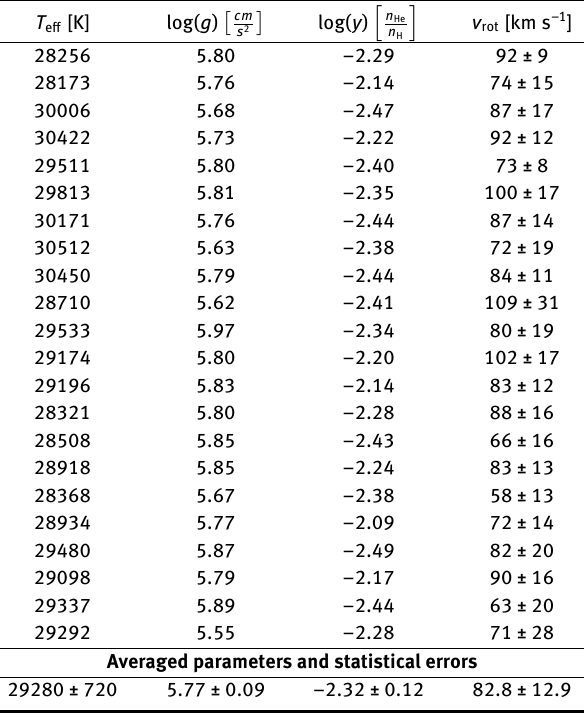
Table 3. Atmospheric parameters of PTF1 J0113. Their values were determined with SPAS using the Keck